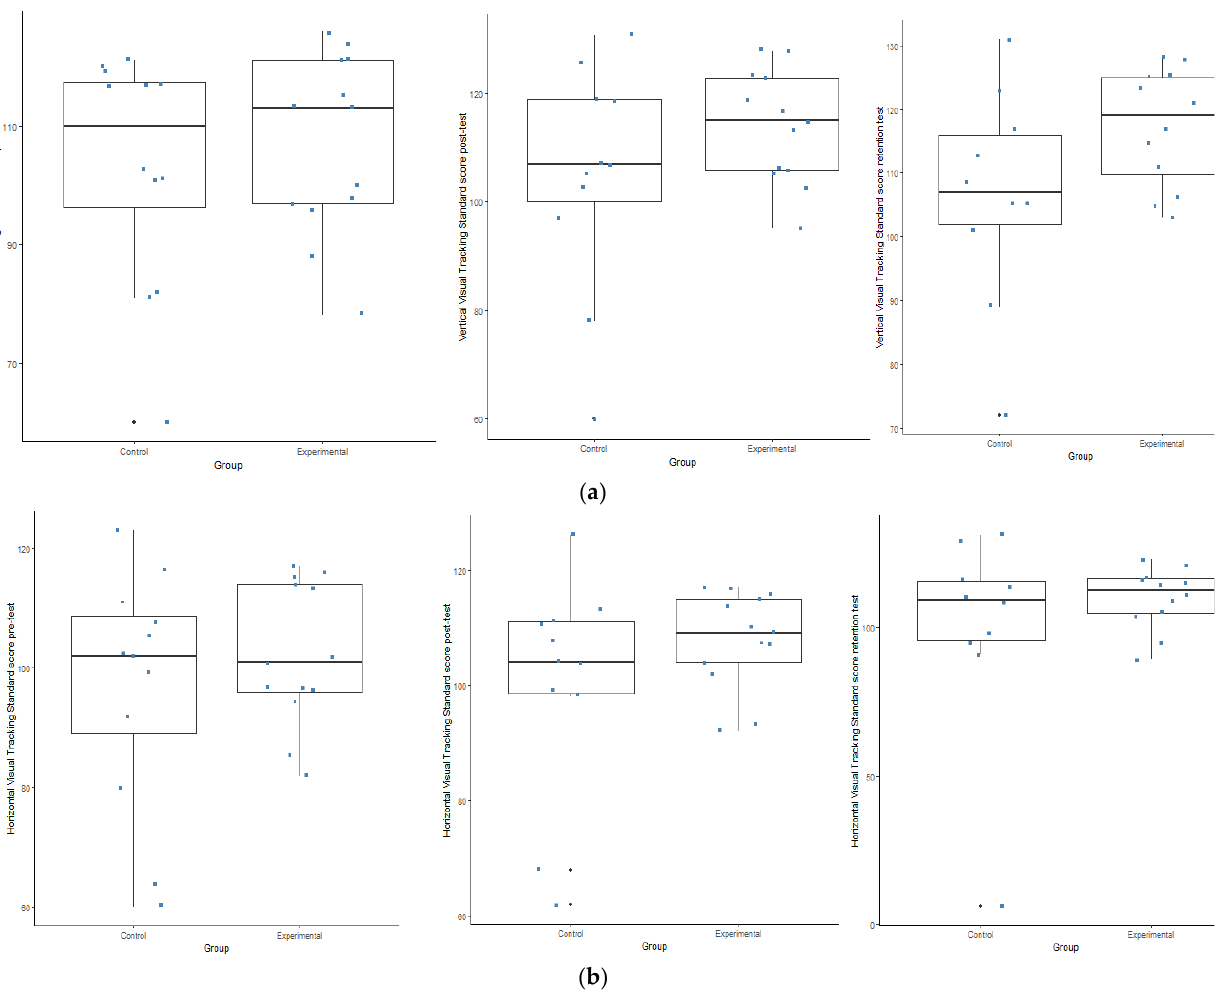
Figure 5. ( a , b ) Box plots indication the interaction within the control and experimental groups during the Development Eye Movement (DEM) test. ( a ) Box plots indicating the interaction within the groups during the pre-; post and retention test during the vertical visual tracking. ( b ) Box plots indicating the interaction within the groups during the pre-; post and retention test during the horizontal visual tracking.